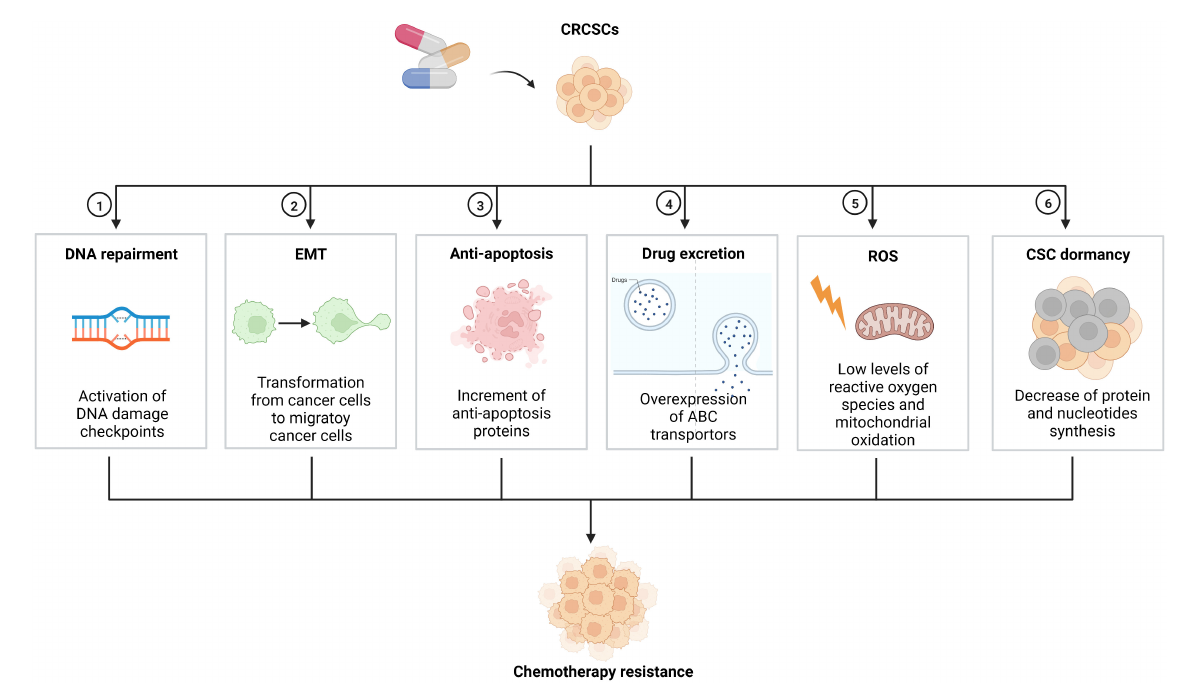
FIGURE1 Mechanisms on chemotherapy resistance of CRCSCs. CRCSCs, colorectal cancer stem cells; EMT, epithelial-mesenchymal transition; ABC, ATP-binding cassette; ROS, reactive oxygen species; CSC, cancer stem